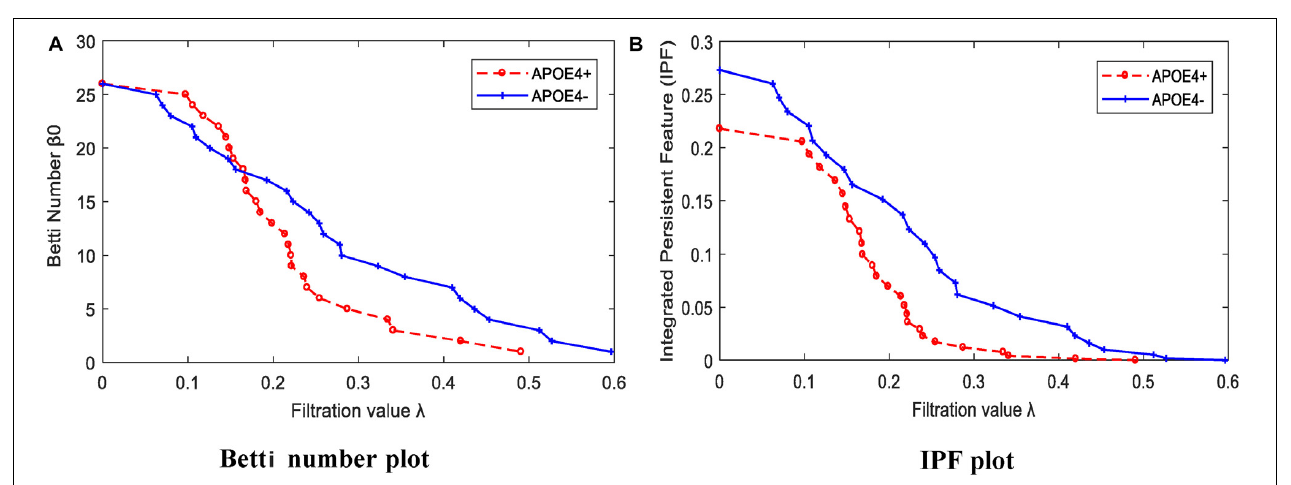
FIGURE 5 | The persistent feature dynamics over filtrations for APOE4+ and APOE4- by (A) Betti number plot and (B) IPF